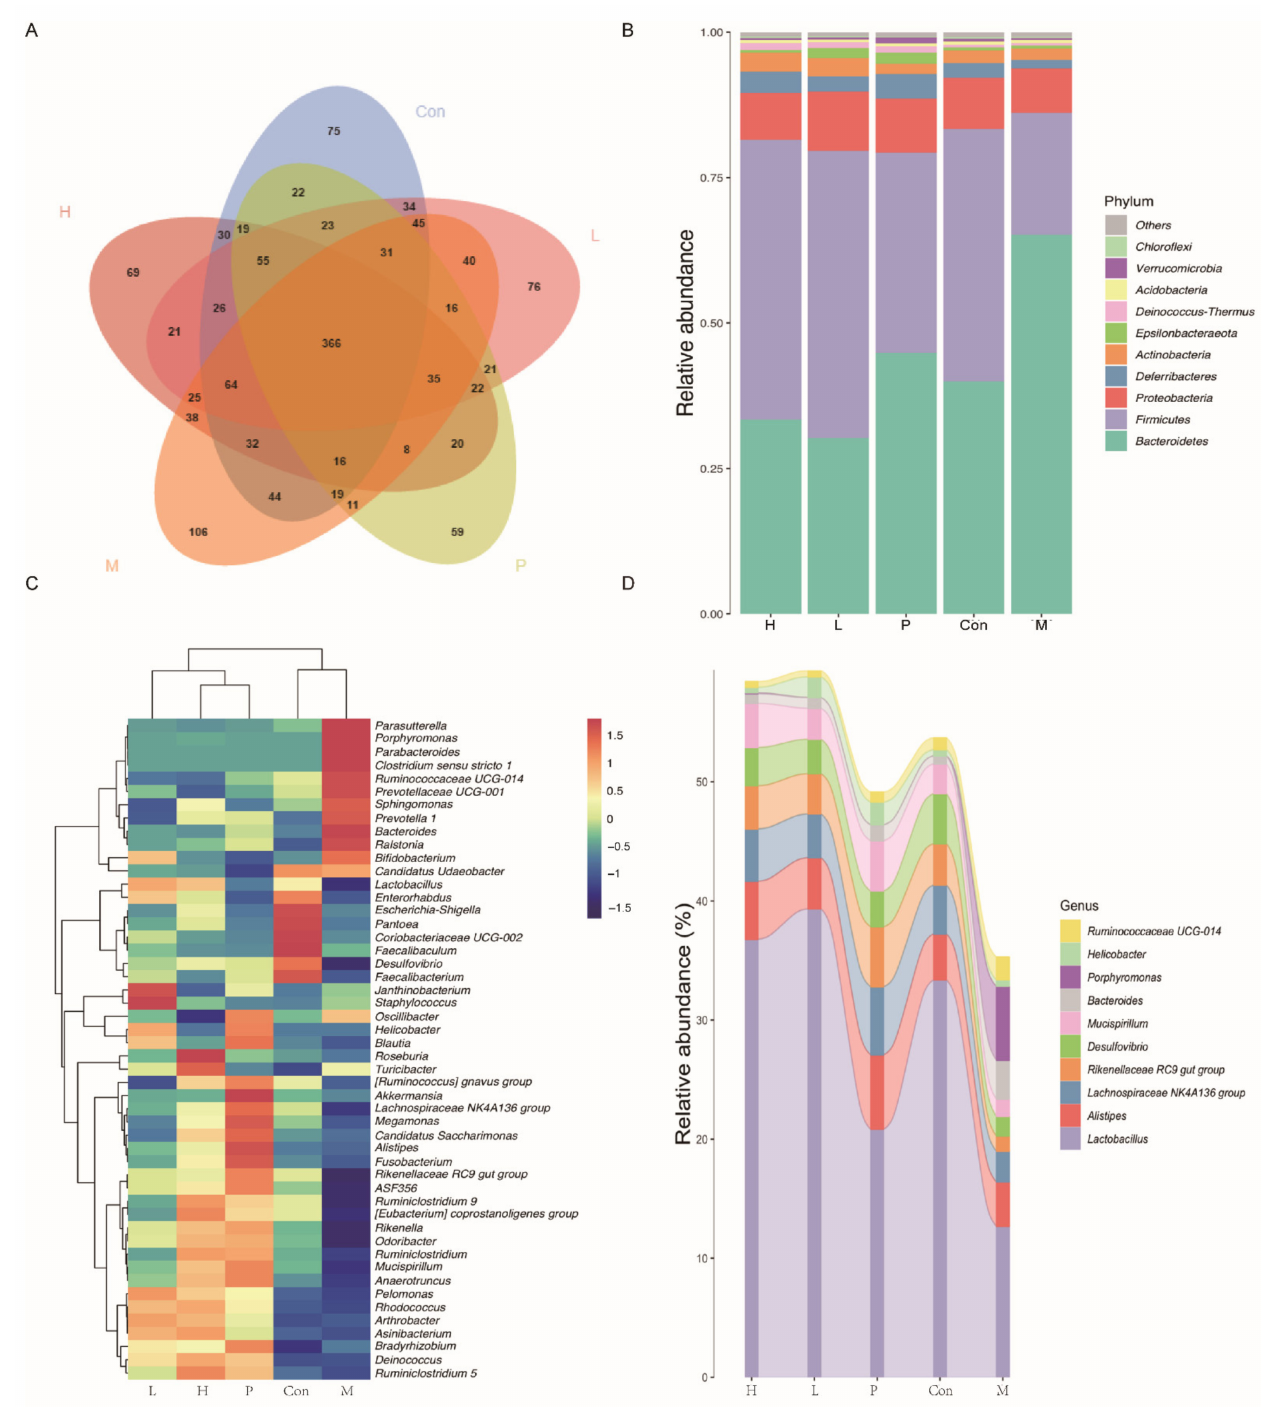
Figure 9. Effects of OPA on gut microbiota. ( A ) Venn chart; ( B ) the relative abundance of gut microbiota at phylum level; ( C ) the relative abundance of gut microbiota at genus level; ( D ) the analysis of sankeyplot of high abundance genus and random